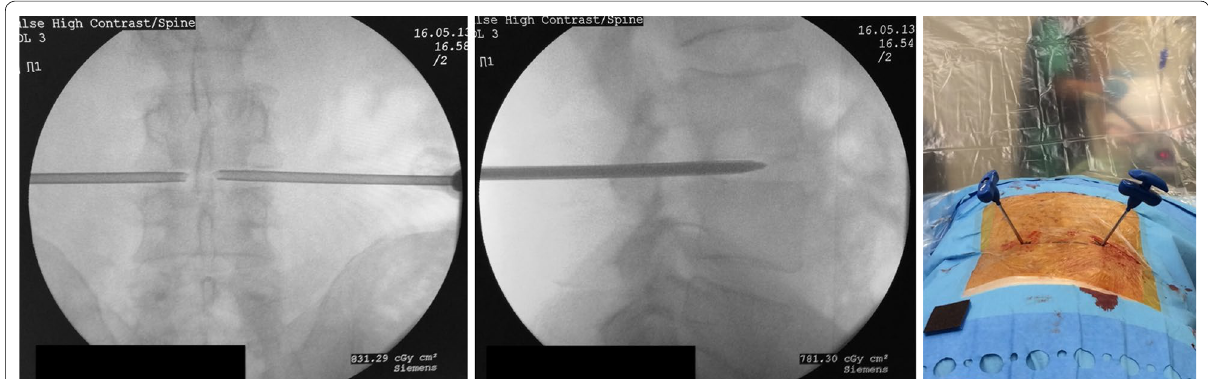
Fig. 3 The needles are advanced inside the disc space. (Left panel) final position of the needles in the AP view; (middle panel) final position of the needles in the lateral view; (right panel) intraoperative position of the